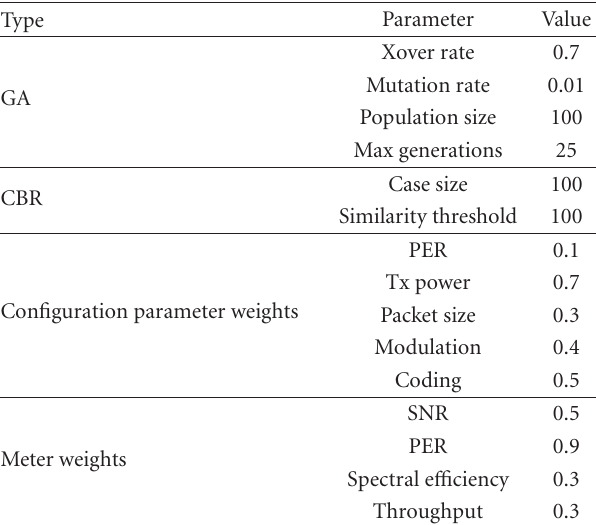
Table 1: Default configuration parameters of the